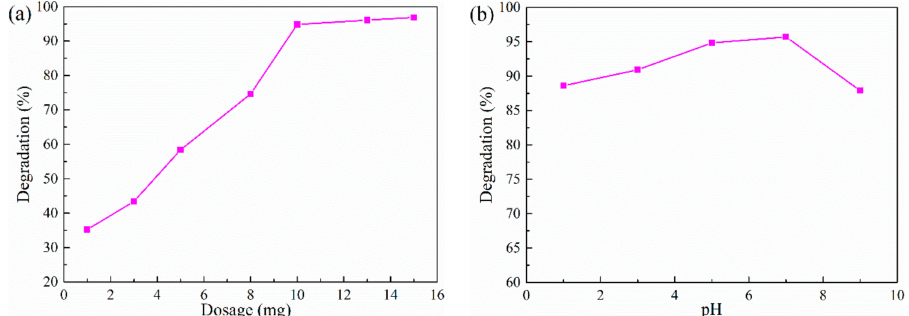
Figure 8. E ff ects of the dosage of Fe 3 O 4 / MnO 2 / Mn 3 O 4 photocatalyst on RhB degradation ( a ).